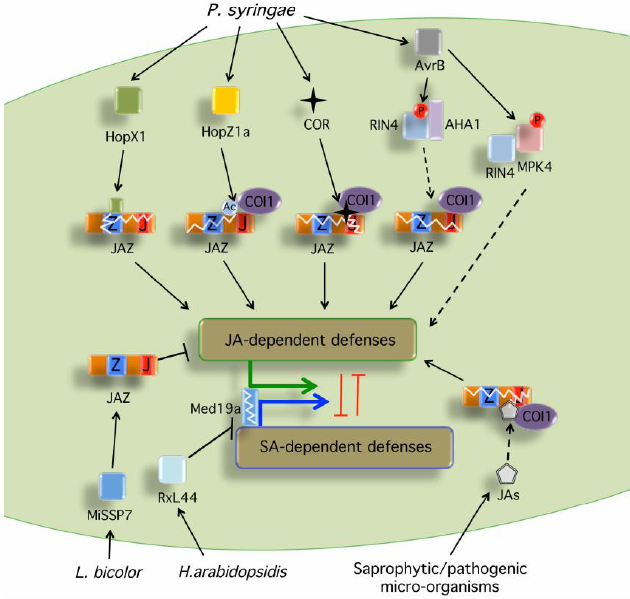
Figure 1. Phytotoxins and microbial effectors targeting the JA signaling components. Several microbes produce JA-Ile precursors or the JA-Ile mimic coronatine that are perceived by the JA-Ile receptor complex and induce degradation of JAZ repressors (see Table 1 for specific examples).